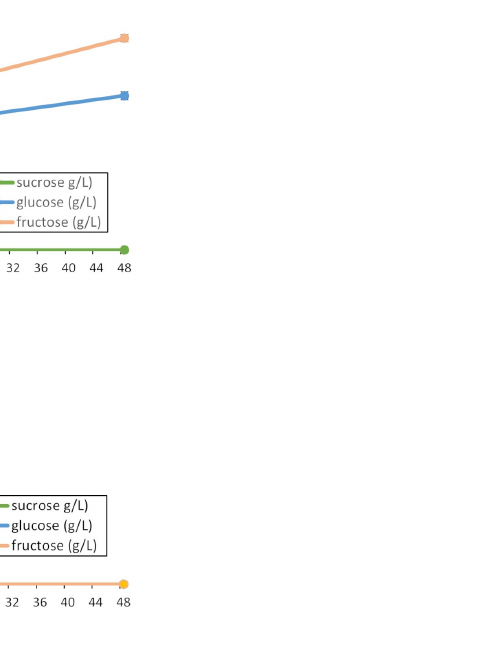
Figure 6. Sugar consumption by Lactobacillus paracasei ssp. paracasei (F-19) in E2 and control assays. The glucose (limiting sugar) consumption in Assay E2 ranged from 14.4 g/L to 8.9 g/L (38.2%) in the first 4 h, similar to the control pathway, where glucose consumption decreases sharply from 15.2 g/L to 9.7 g/L (36.1%) at the same time. In addition, fructose showed a consumption range of 16.0 g/L to 14.7 g/L (8.1%) during the first 24 h of fermen ‐ tation. Some authors have reported a similar fermentation pathway using media with mo ‐ lasses as substrate, in which the Lactobacillus strains also utilized glucose slightly faster than fructose during their growth [39]. These results demonstrate that sugarcane molasses, with the sole supplementation of selected minerals and yeast extract, after the proposed pretreatment, is a medium with the right nutrient balance to achieve significant probiotic biomass production when using LPPF19 as a reference. 3.5. Cost of Molasses Culture Medium (MCM) The cost of raw materials used in the preparation of MCM is presented in Table 5. Data refer to the market price in the Dominican Republic for molasses [40] and Spain for the rest of the ingredients) in 2020. The total cost of raw materials in preparing molasses culture media at the laboratory level is 1.23 EUR/L, while at the industrial level, it is 0.83 EUR/L. Even if the manufacturing cost of one product in ordinary chemical processing plants varies depending on many factors, such as operating labor and maintenance costs, raw materials are one of the principal components; it is estimated that they represent 33% of manufacturing costs [41]. In this case, the manufacturing cost of the molasses culture medium at laboratory levels could be estimated at 3.73 EUR/L and industrial levels at 2.51 EUR/L. Both costs are dramatically lesser than the cost of the control medium used in this research (11.93 EUR/L, 2020, Spain, price market data).